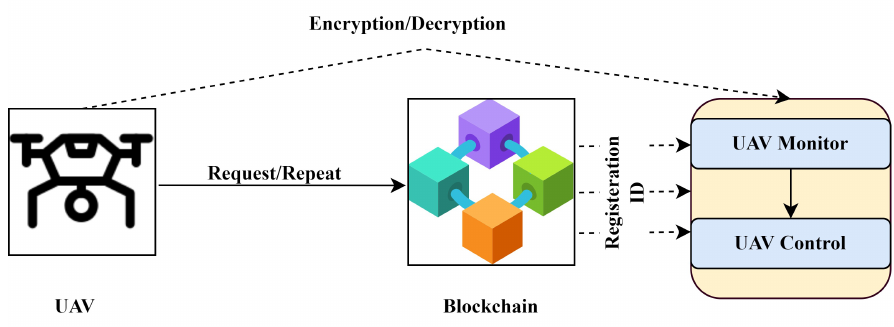
Figure 5. IoT security module: generic